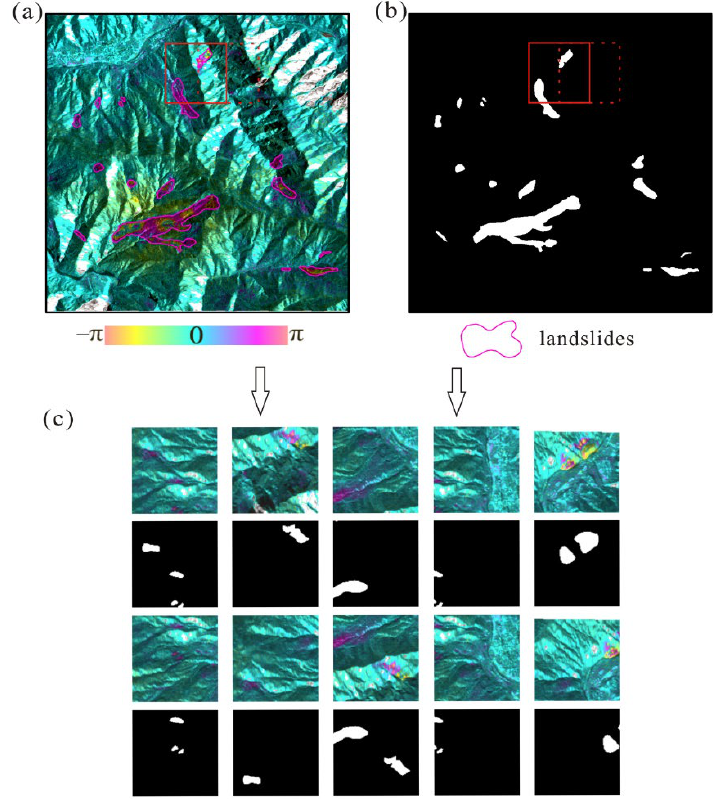
Figure 4. Data production. ( a ) InSAR imagery, ( b ) landslides binary map, ( c ) image patches.